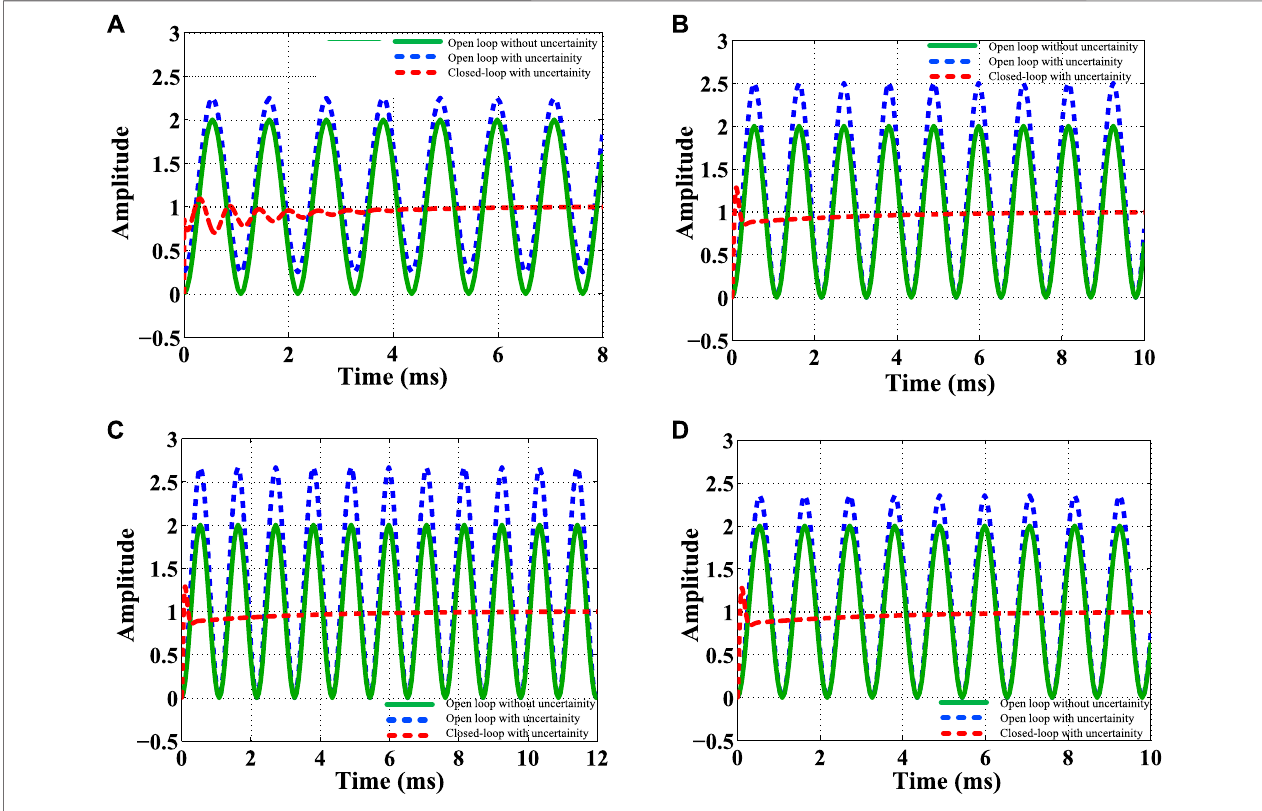
FIGURE 7 | Comparison of step responses using open and closed-loop: (A) for Figure 5A; (B) for Figures 5B,C; (C) for Figure 5D; (D) for Figures 5E,F .